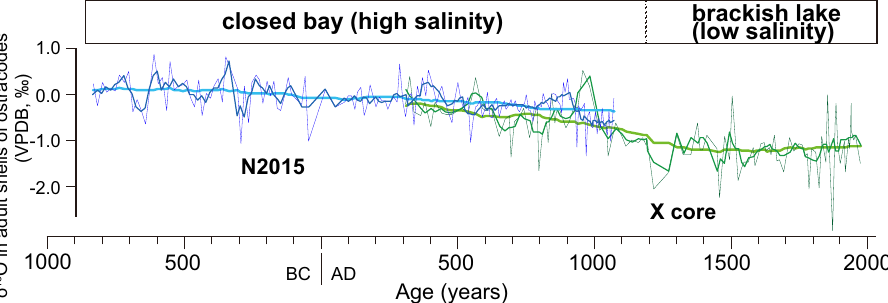
Figure 2. The δ 18 O records from ostracode shells of Bicornucythere bisanensis . The data from the N2015 core (blue) were represented by adding the records from the X core (green) 19 . The coloured thick, thin and extra- thin lines suggest 500 yr and 50 yr running mean values and measurement values, respectively. Environmental changes were derived from fossil ostracode assemblages 18